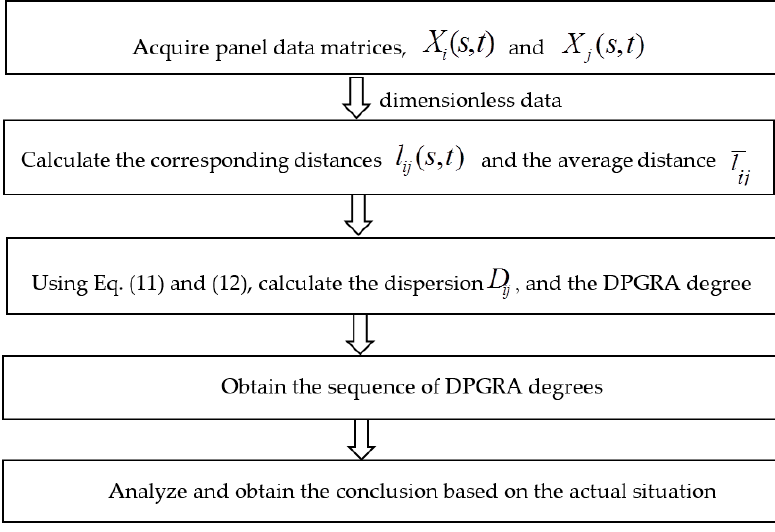
Figure 4. The steps diagram of DPGRA model.